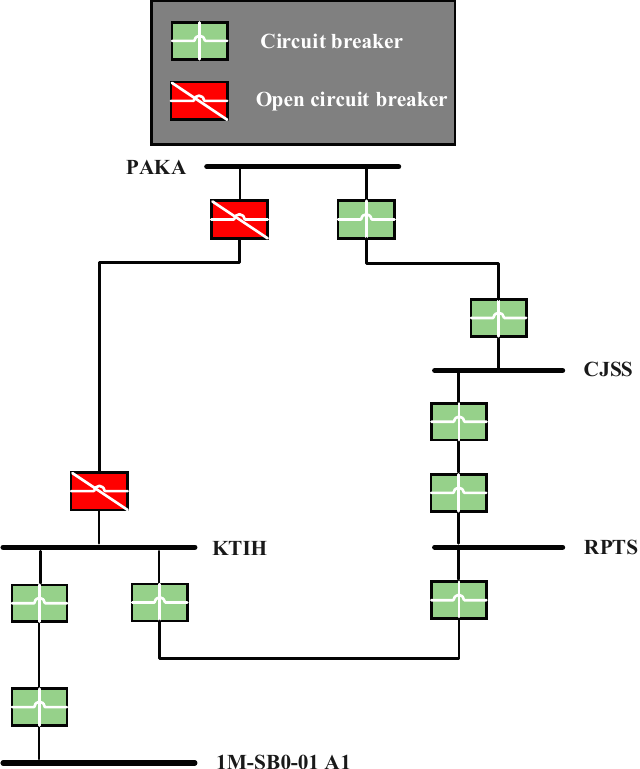
Figure 3. Islanding Scenario 1 of the test system.